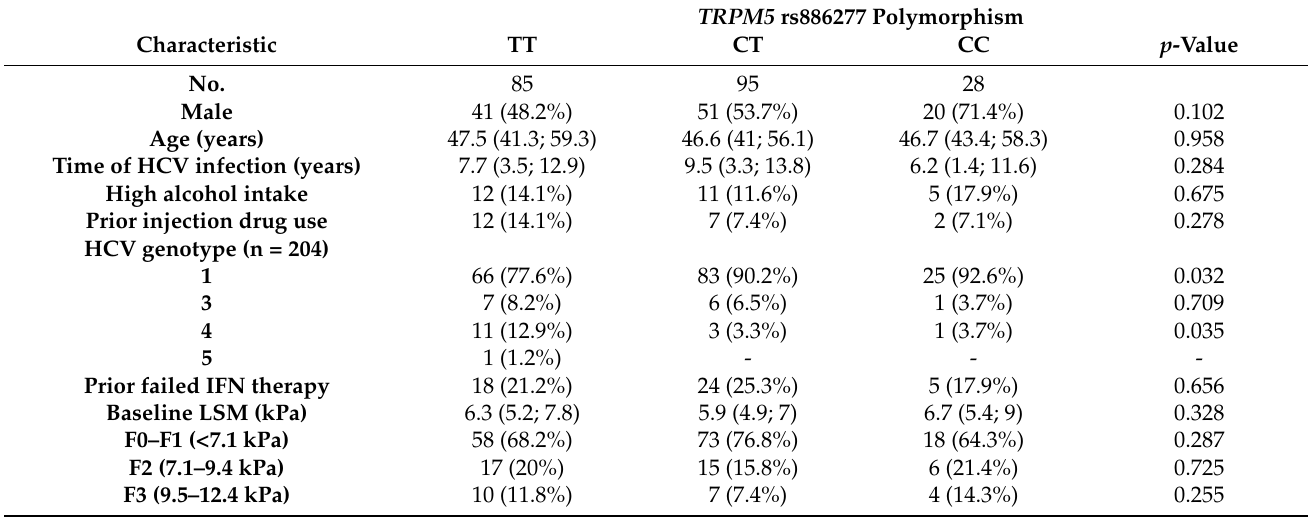
Table 1. Clinical and epidemiological characteristics of HCV-infected patients at baseline. TRPM5 rs886277 Polymorphism